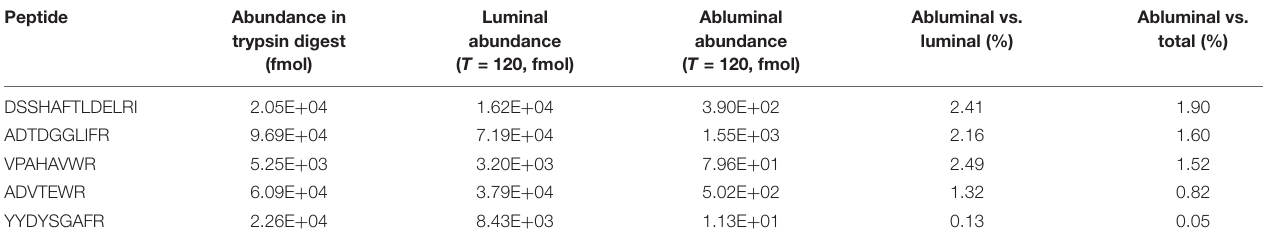
TABLE 2 | Tryptic peptides of sMTf cross an in vitro BBB. Peptide Abundance in trypsin